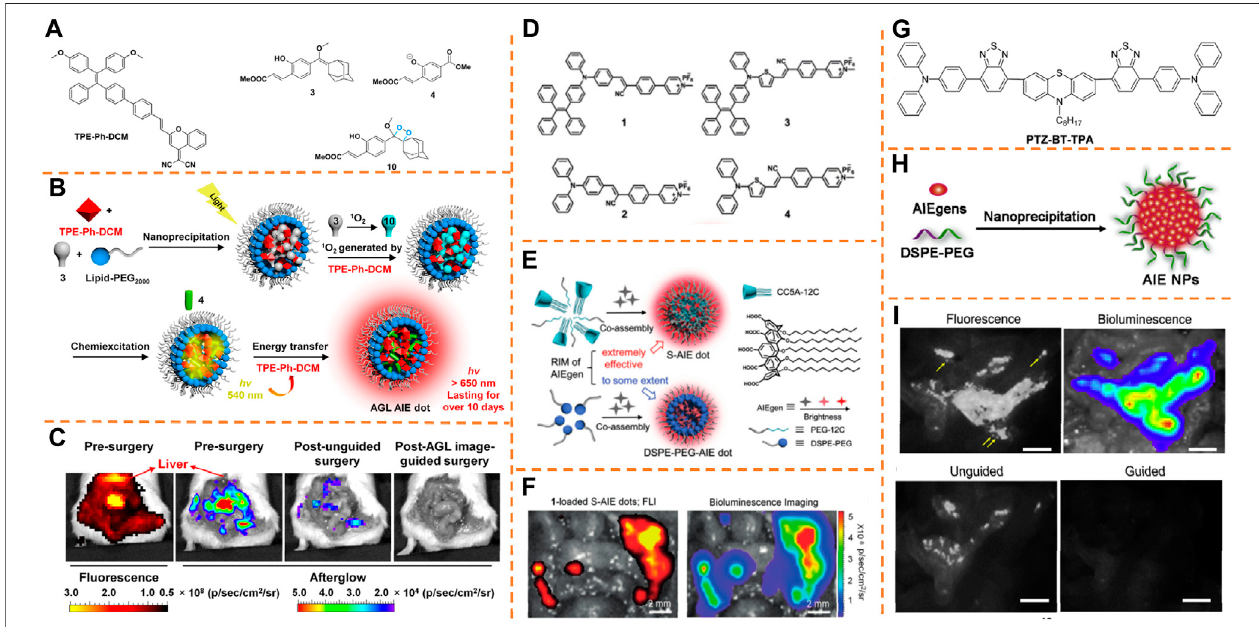
FIGURE 4 | (A) Chemical structures of compounds 3, 4, 10, and TPE-Ph-DCM. (B) Schematic explanation of the mechanism for enlarged NIR afterglow luminescence of the AGL AIE dots. (C) Representative NIR fl uorescence and afterglow imaging of the peritoneal carcinomatosis – bearing mice. Adapted with consent from Ni et al. (2019). (D) Chemical constructions of the AIEgens. (E) S-AIE dots and DSPE-PEG-AIE dots and chemical construction of CC5A-12C. (F) Fluorescence imaging and bioluminescence imaging of the intraperitoneal tumor nodules from mice after intravenously injecting 1-loaded S-AIE dots for 24 h. Adapted with consent from Chen et al. (2020). (G) Chemical structure of PTZ-BT-TPA. (H) Schematic illustration preparing AIE NPs with a nanoprecipitation approach. (I) Representative fl uorescence and bioluminescence imaging of the peritoneal carcinomatosis – bearing mice. Adapted with permission from Qi et al.